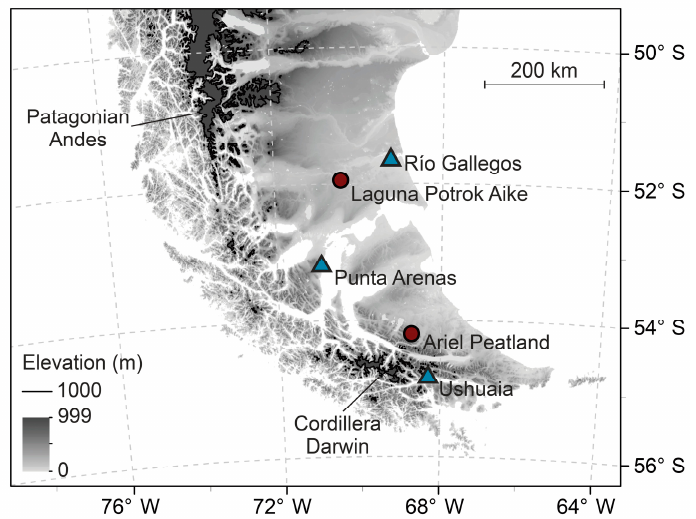
Figure 1. Digital elevation map of Southern Patagonia. Also shown are major cities (cyan triangles) and field sites (red dots) discussed in this paper, and the elevation contour of 1000 m asl. The digital elevation model is from the Global Multi-resolution Terrain Elevation Data 2010 (GMTED2010) at 30-arc-second resolution [47] .